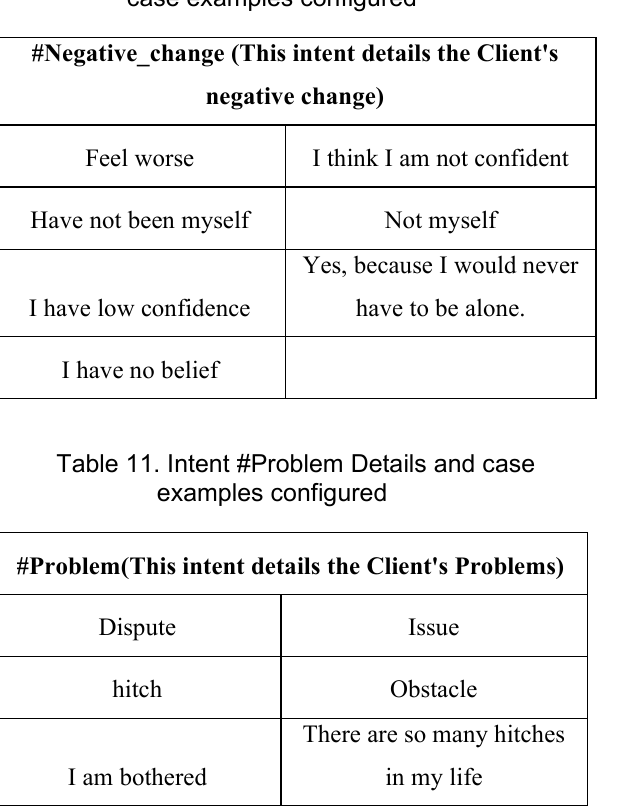
Table 10. Intent #Negative_change Details and case examples configured